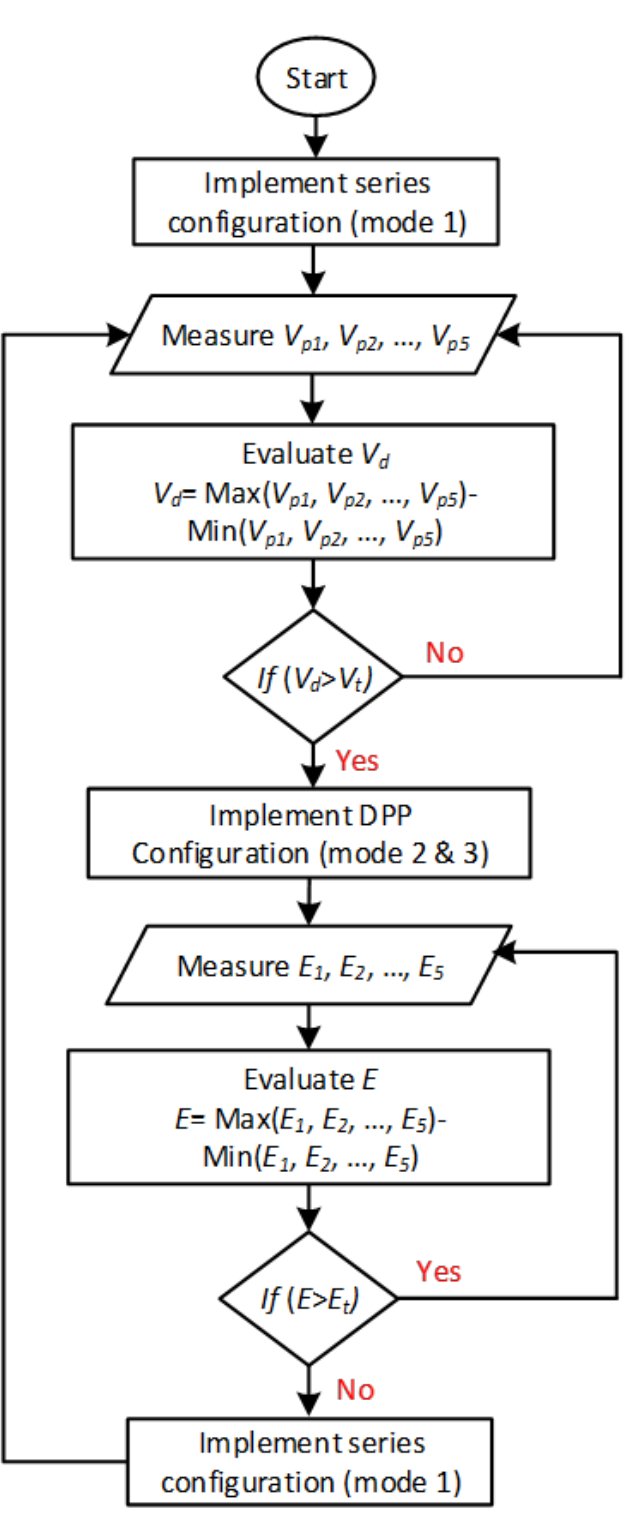
Figure 8. Flow chart for the proposed reconfiguration.